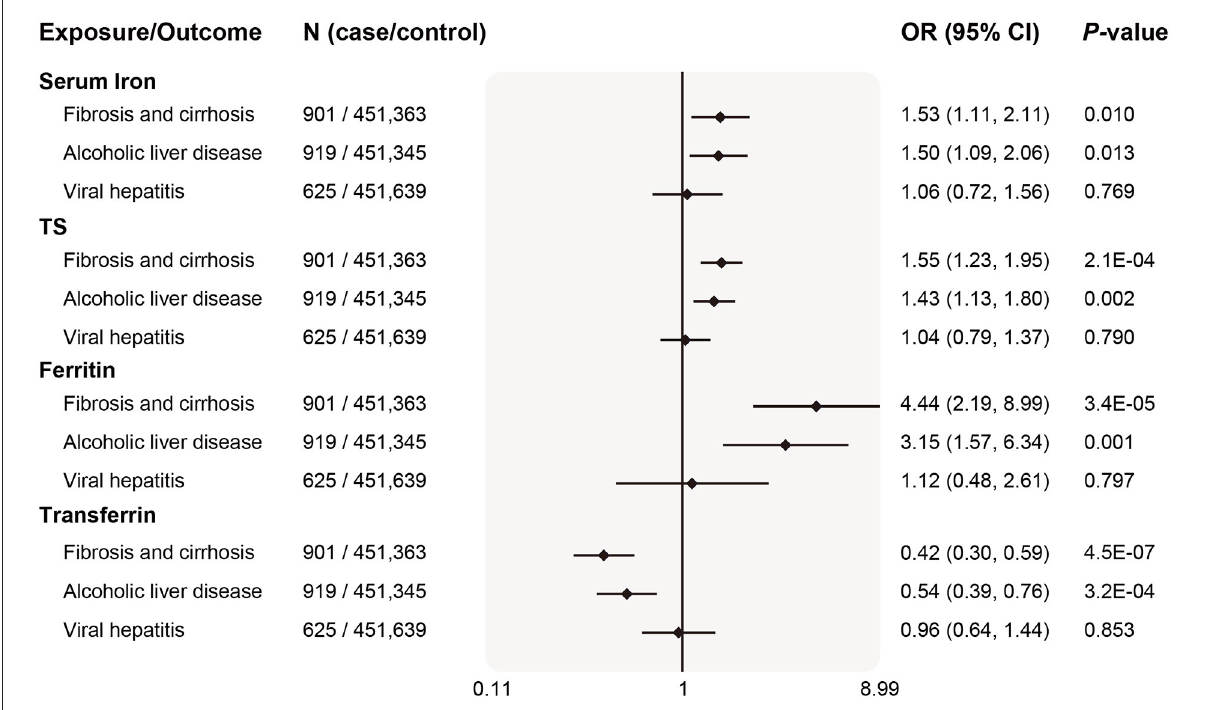
FIGURE6 Replication of associations of genetically predicted iron status and liver diseases in the updated database. The ORs (95% CI) of liver diseases (ALD, fibrosis and cirrhosis, viral hepatitis) per SD increase of iron status biomarkers were estimated using fixed-effect inverse-variance weighted meta-analysis. OR, odds ratio; 95% CI, 95% confidence interval; ALD, alcoholic liver disease; SD, standard